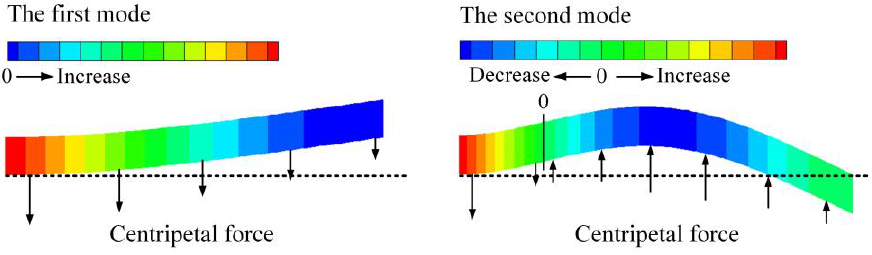
Figure 8. The frequency of the second mode as a function of the nondimensional voltage and the nondimensional velocity ( a ) The effect of both applied voltage and fluid velocity on the resonant frequency; ( b ) The effect of voltage on the frequency for different fluid velocities; and ( c ) The effect of velocity on frequency for different applied voltages.